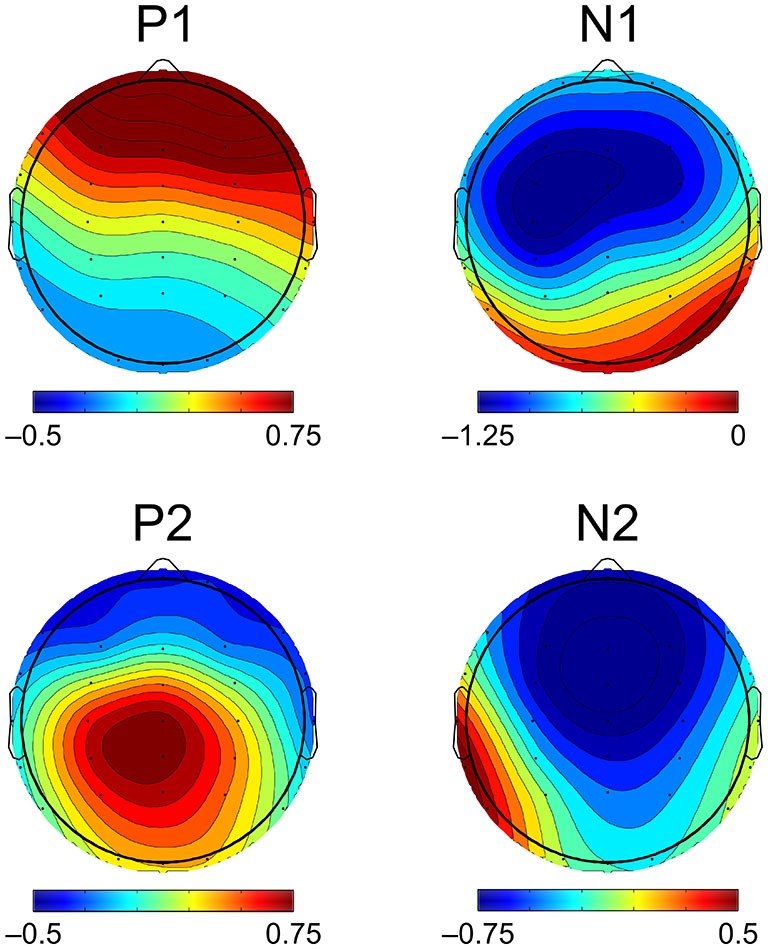
Topographic distribution of CAEP components. CAEP component topography is visualized here as the scalp distribution of mean amplitudes of the grand averaged CAEP across all participants and ages. Scalp maps show mean amplitudes measured within the same time window widths used for statistical analyses (P1, N1, P2 = 40 ms, N2 = 70 ms), centered on the peak component latencies of the grand average. N1, P2, and N2 mean amplitudes shown here were measured using the mean amplitude of the preceding component as a baseline, while P1 mean amplitude was measured using the mean amplitude of the prestimulus period as a baseline.